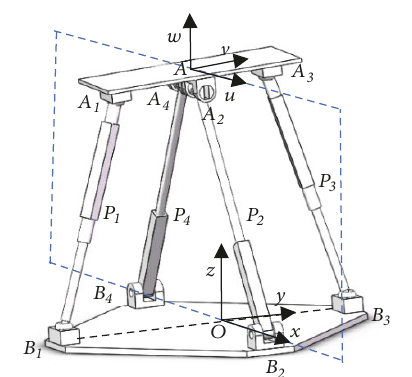
Figure 2: Schematic model of the 2-RPU&2-SPS SPM.